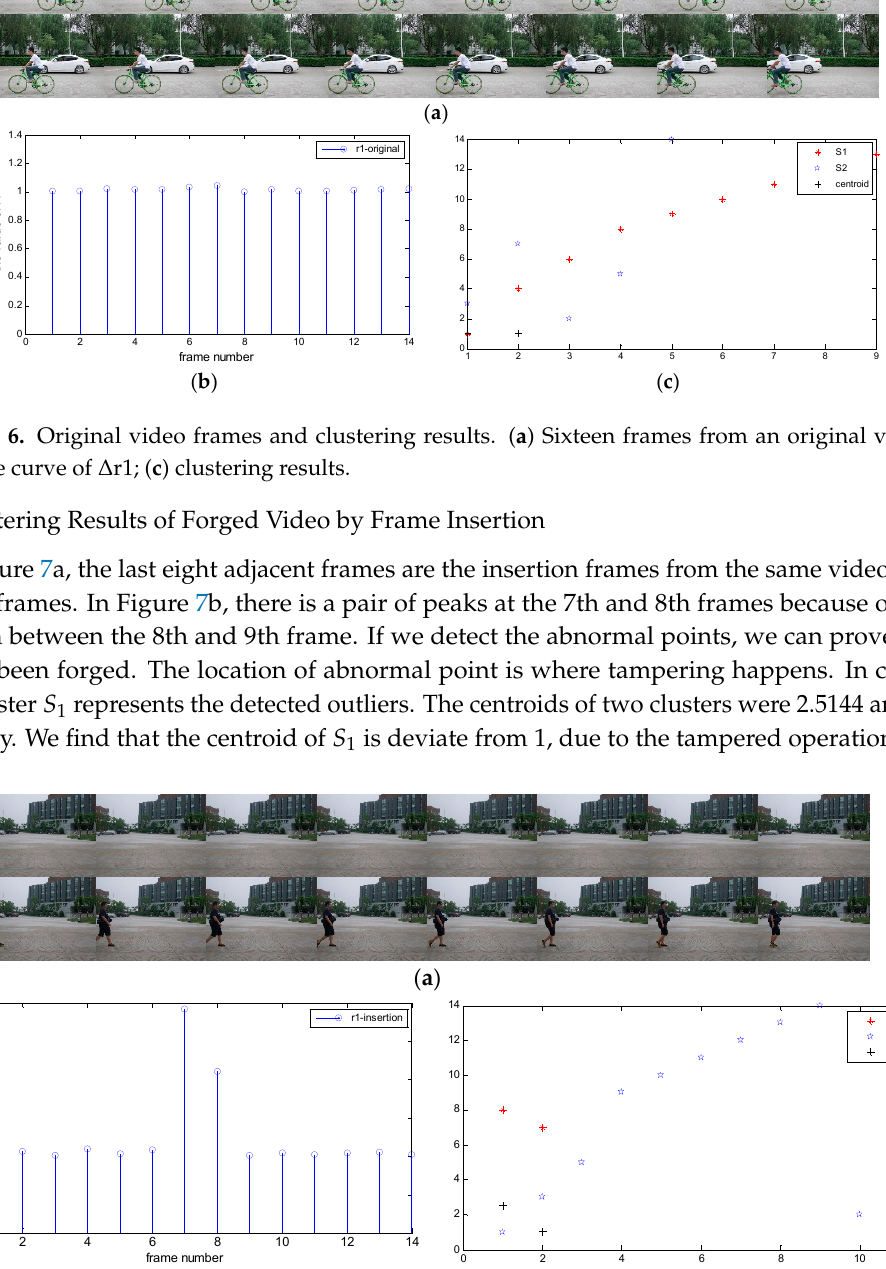
( c ) Figure 8. Frame deletion and clustering results. ( a ) Sixteen frames from a video tampered by frame deletion; ( b ) The curve of ∆r1 ; ( c ) clustering results.